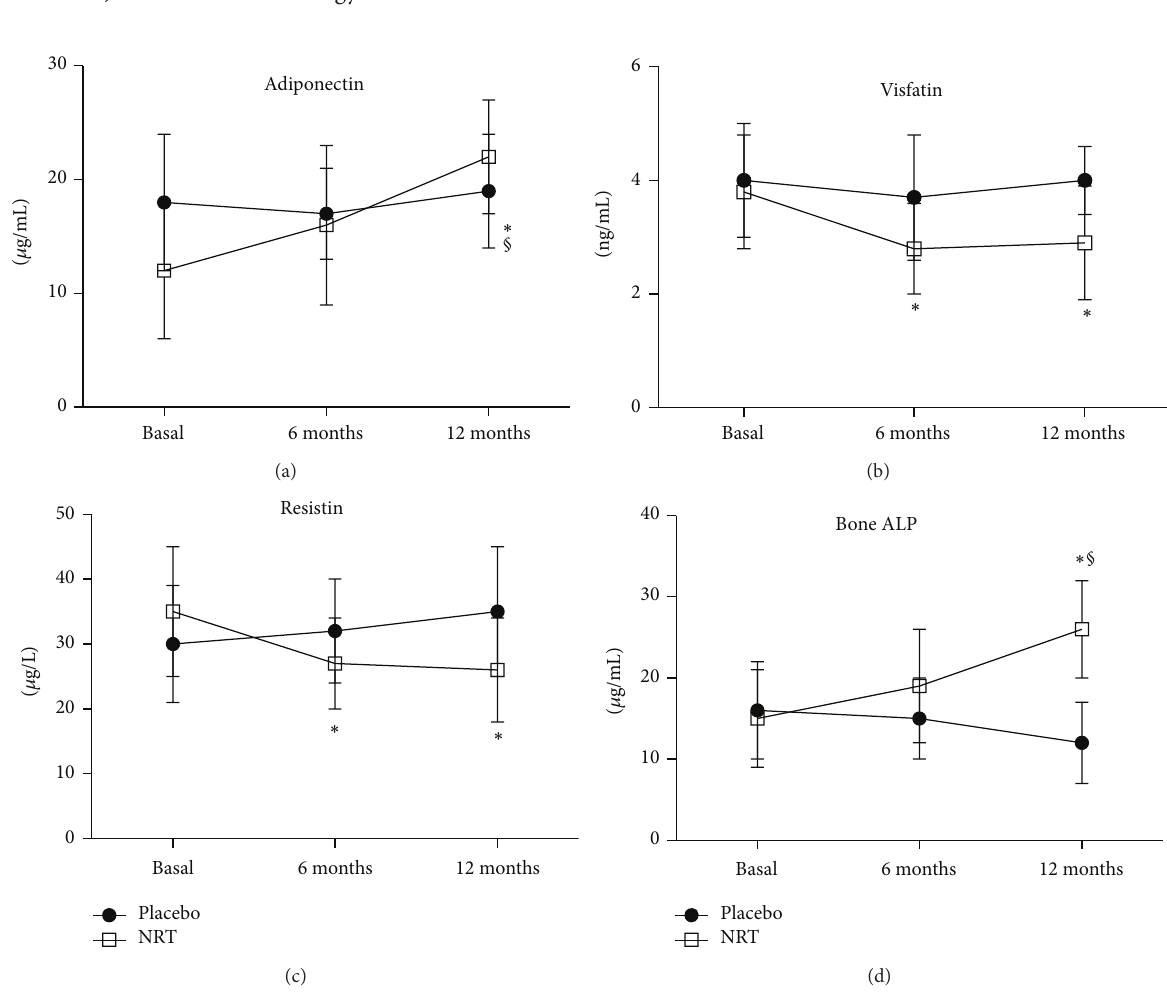
b-ALP, visfatin, and resistin, also adiponectin levels were significantly changed in NRT group, compared to placebo (Table 2 and Figures 2 and